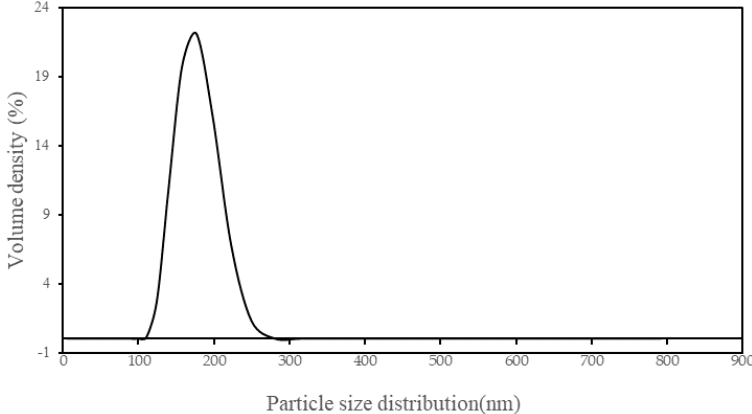
Figure 2. Particle size distribution of the